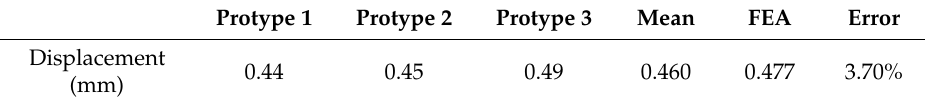
Figure 10. Load–displacement diagram of the experimental test. Table 3. Comparison between the FE simulation and experimental tests of the optimized structure.